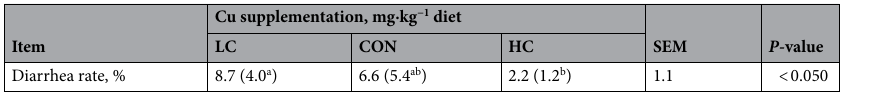
Table 2. Effects of dietary copper on the diarrhea rate of suckling piglets [Mean (SD)]. a,b Values within a row without a common superscript letter are significantly different ( P < 0.05).